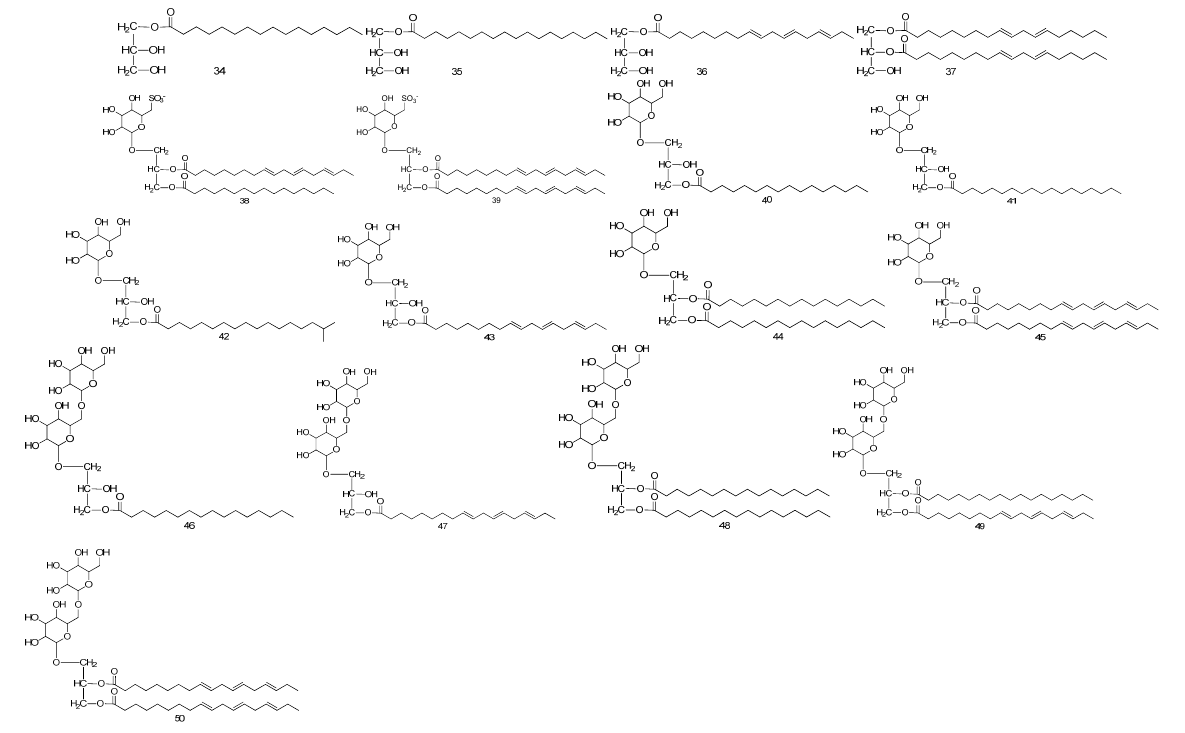
Figure 5. The chemical structures of glycerides identified from Fructus Malvae .